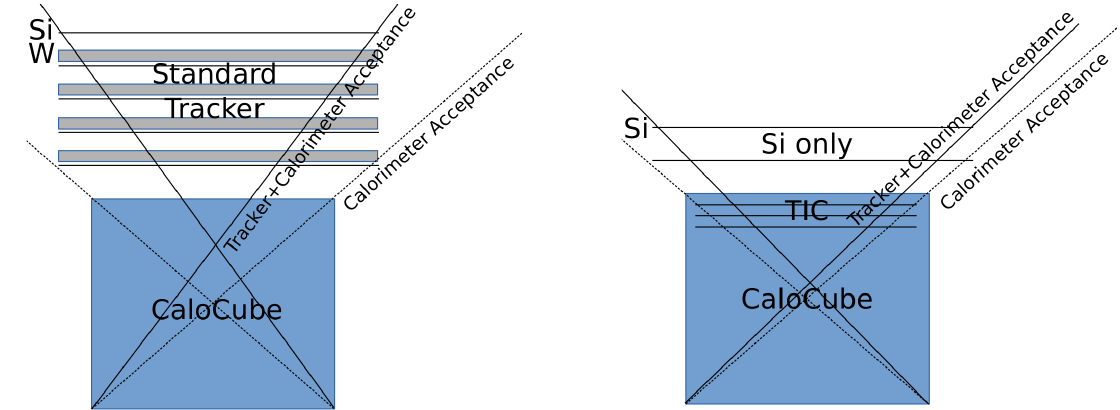
Figure 10. Schematic design of the two different methods for angle reconstruction: On the left , the standard approach of a Si+W tracker external to the calorimeter, and on the right , the TIC approach of a Si tracker inside (and a couple of Si layers outside) the